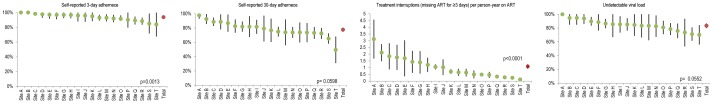
Proportion (and 95% CI) of patients reporting 100% adherence during 3 days or 30 days preceding interview, rate of treatment interruptions (missing ART for ≥3 days) per person-year on ART (95% CI), and proportion (95% CI) of patients with undetectable viral load by site.